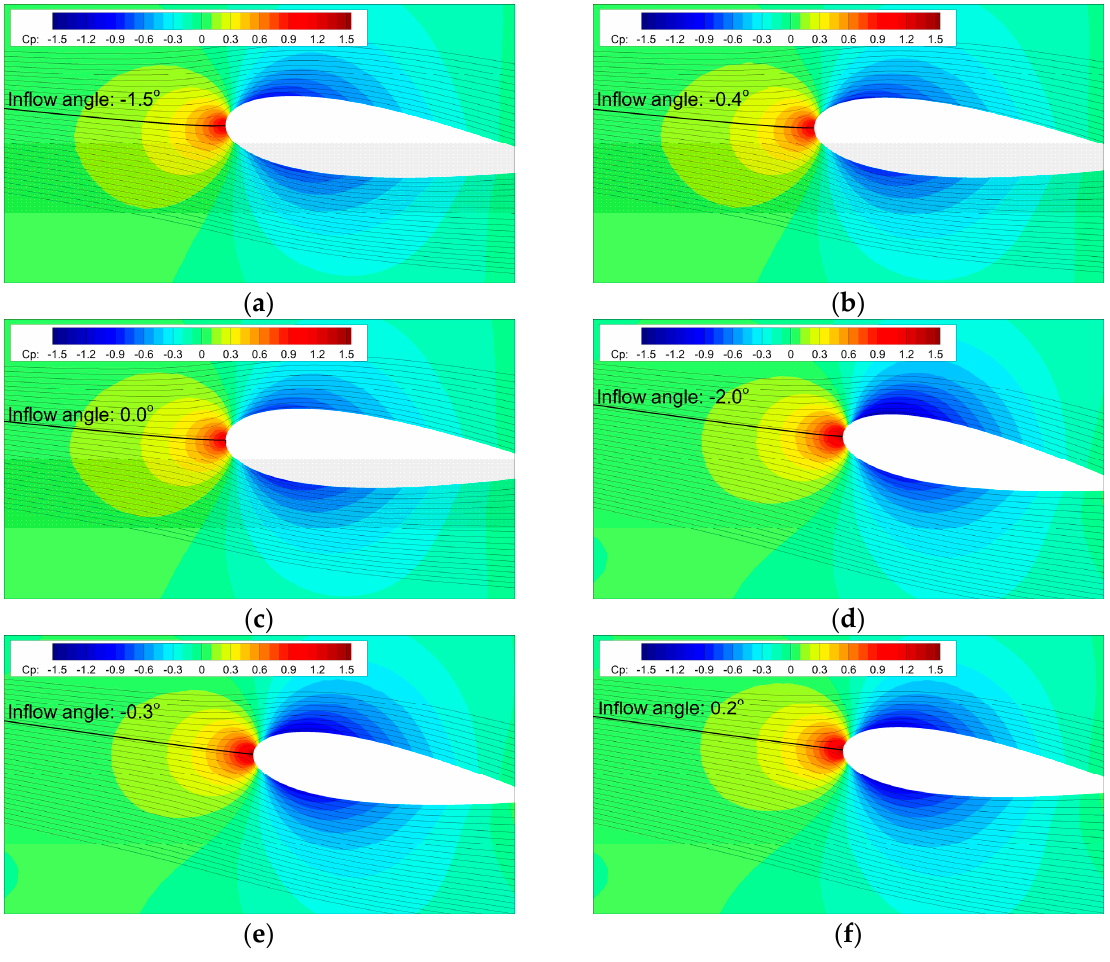
The effectiveness of the twisted rudder TR-fin on the compensation of the onset flow